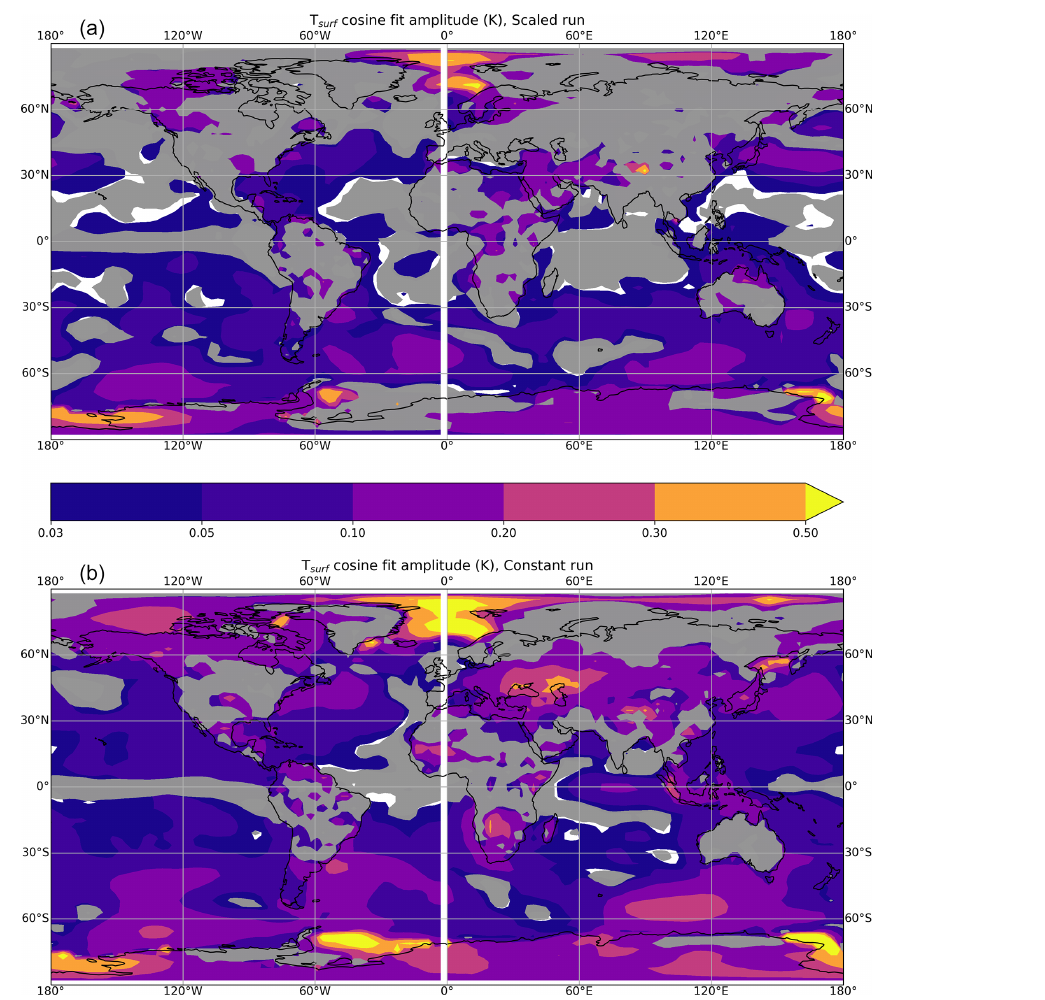
Figure 5. (a) Geographical variation of the amplitude of the sinusoidal trigonometrical fit to surface temperature (K) whose globally averaged counterpart is shown in Fig. 4b in the scaled run; i.e. yellow colours are where the fitted curve has an amplitude of > 0 . 5K. Grey shaded areas show where the amplitude is less than 2 standard errors of annually averaged T surf in the control integration and are used to denote areas where the response is likely to be noise; note nonlinear contour interval. (b) As panel (a) but for the constant